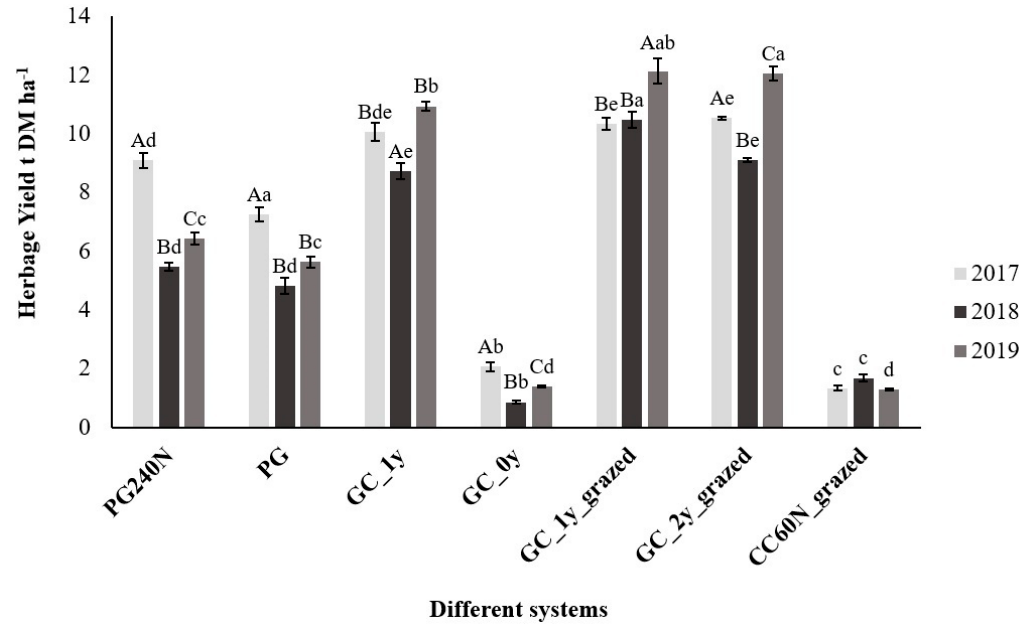
Figure 4. Average herbage yield (t DM ha − 1 ) of the different sward types investigated over the three years (2017, 2018 and 2019). Different upper-case letters indicate significant inter-annual differences. Different lower-case letters indicate significant differences between the various sward types. Table 4. The N-yields (kg N ha − 1 ) of the different sward types investigated over the three years (2017, 2018 and 2019). Different upper-case letters indicate significant inter-annual differences. Different lower-case letters indicate significant differences between the various sward types. SEM are shown in